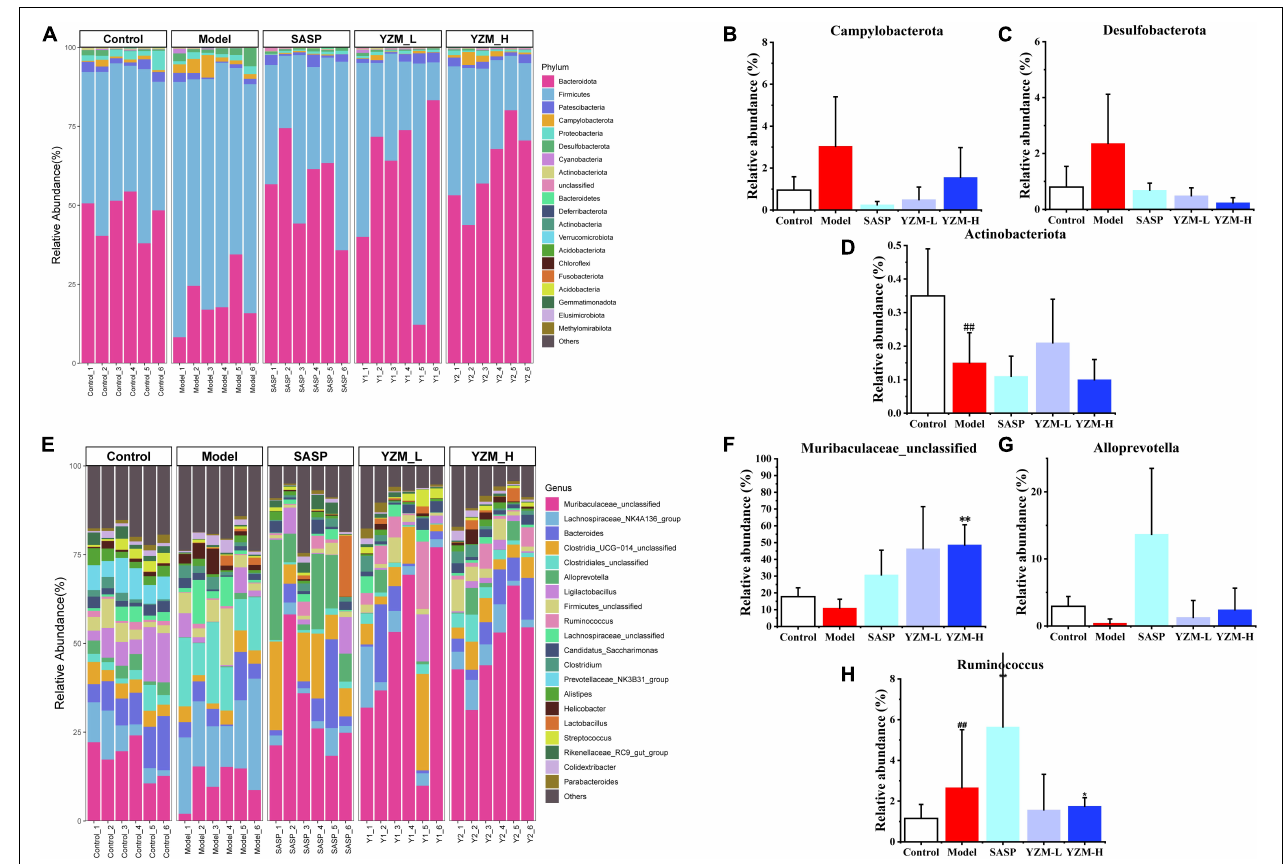
FIGURE 5 | Impacts of YZM at phylum and genus level. (A) The proportion of intestinal microbiota at phylum level (B–D) . Relative abundance of Campylobacterota , Desulfobacterota , Actinobacteriota . (E) The proportion of intestinal microbiota at genus level. (F–H) Relative abundance of Muribaculaceae unclassified , Alloprevotella , Ruminococcus . ## p < 0.01 vs. control; ** p < 0.01 vs. model, * p < 0.05 vs.